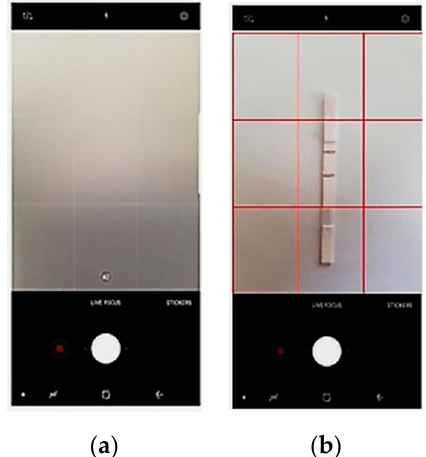
Figure 14. ( a ) Android smartphone (Samsung Galaxy) camera view with a 3 × 3 grid positioning and ( b ) LFA strip ROI positioned in the center box.